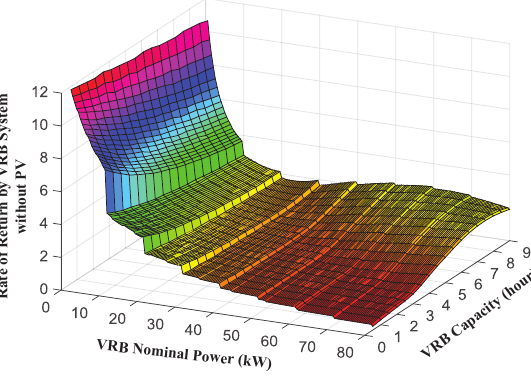
Figure 13. Rate of return (ratio between the net benefit and investment cost) of the VRB system without